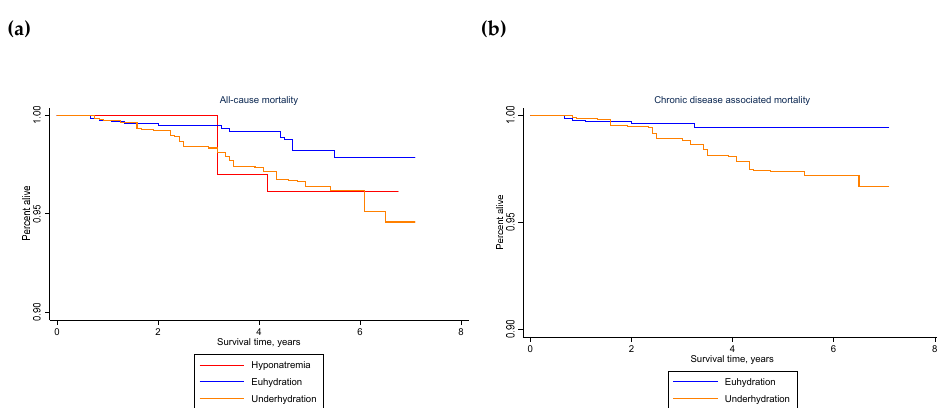
Figure 3. Kaplan–Meier curves for ( a ) all-cause and ( b ) chronic disease-associated mortality Figure 3. Kaplan – Meier curves for (a) all-cause and (b) chronic disease-associated mortality associated with hyponatremia, euhydration, or underhydration in 2009–2012 for U.S. adults aged 51–70 years. Hyponatremia: serum sodium below 135 mmol/L; euhydration: serum sodium 135–144 mmol/L, urine volume 50 mL or higher, and urine osmolality below 500 mmol/kg; underhydration: serum sodium 145 mmol/L or higher, urine volume below 50 mL, or urine osmolality 500 mmol/kg or higher.